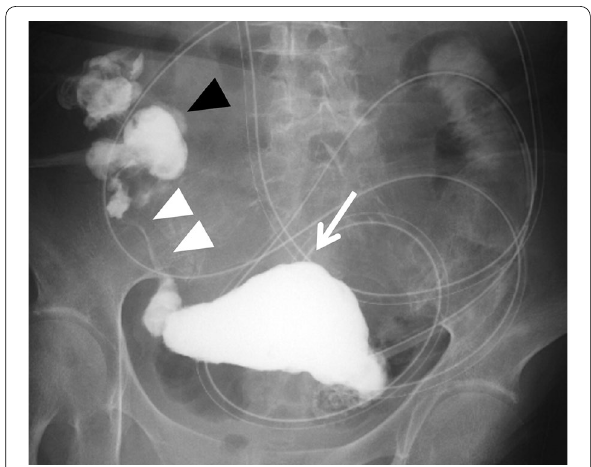
Fig. 2 Contrast study from the transnasal decompression tube shows distention (arrow), stenosis (white arrowhead) of the terminal ileum, and normal ascending colon (black arrowhead)